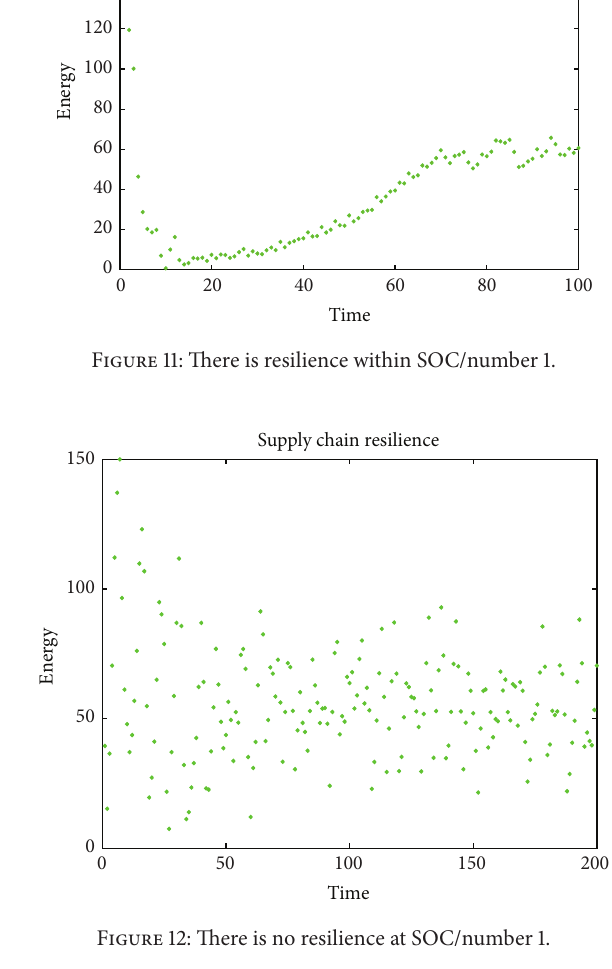
Figure 15. The parameters of number 1 are used in this